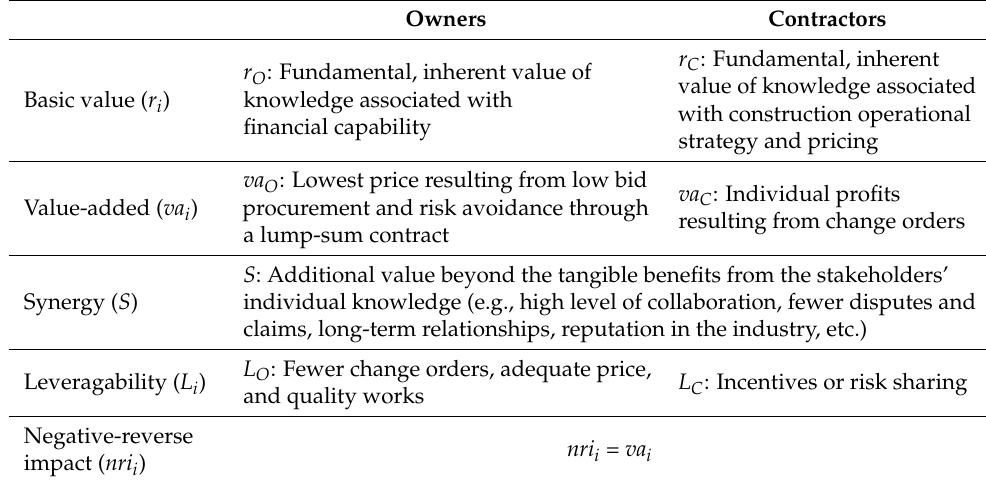
Table 3. Owners’ and contractors’ tacit knowledge value in construction